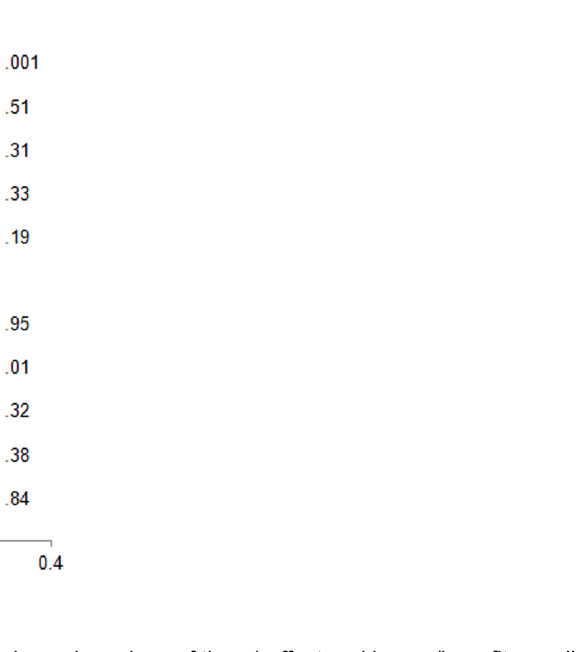
Figure 2. Standardized estimates, 95% confidence intervals, and p-values of time 1 affect and harms/benefits predicting time 1 → time 2 change in moral